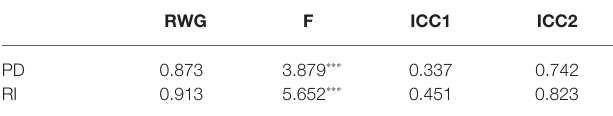
TABLE 1 | Data aggregation test